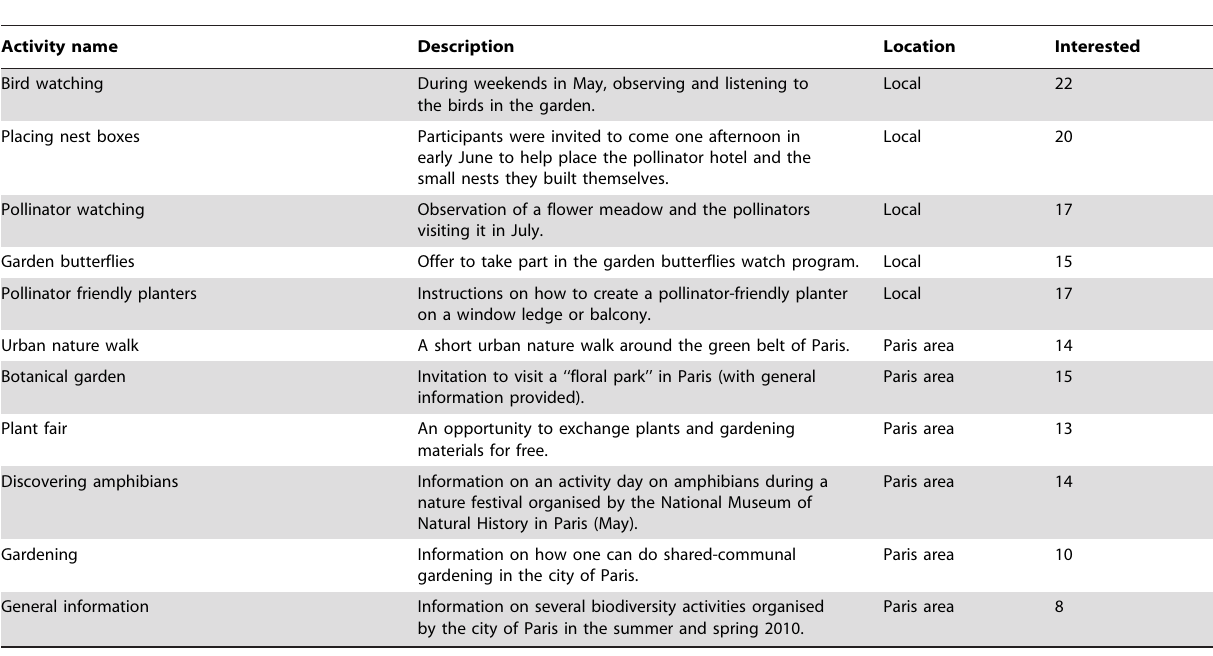
Table 2. Description of the eleven further activities proposed to participants by the during the activity